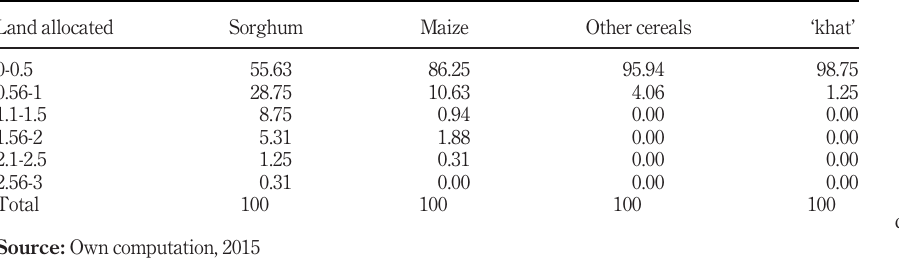
Table III. Households ’ (%) cropland